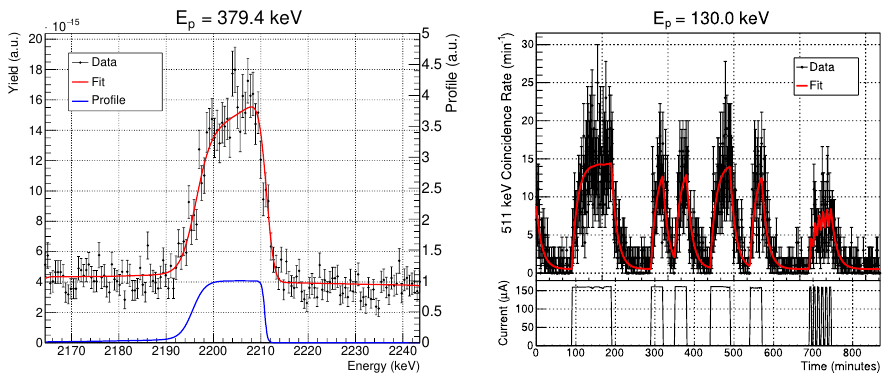
Figure 3: On the left an example of the γ -shape analysis for the HPGe data of the primary transition to the 5691 keV state of 14 N. The shape of the γ -peak is modeled both by the exponential drop in the cross-section and by the target profile (in blue). On the right an example of the fit for the 12 C( p , γ ) 13 N activation measurement with the BGO. During the irradiation, the event rate increases and then saturates. Whereas when the beam is stopped, the exponentialy decay is